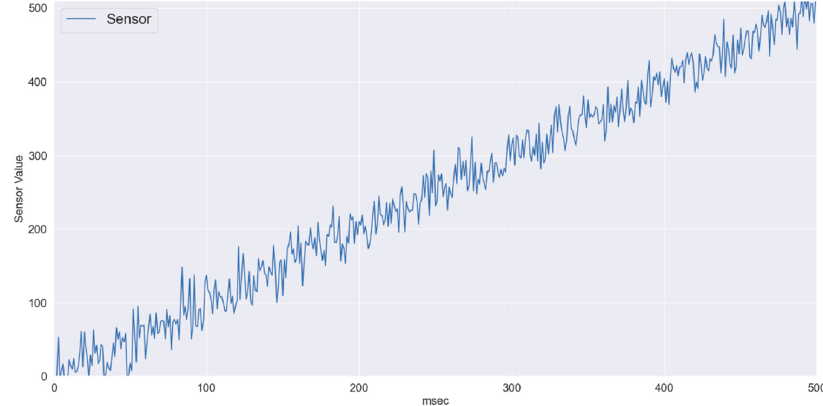
Figure 3. Slow changing sensory data.